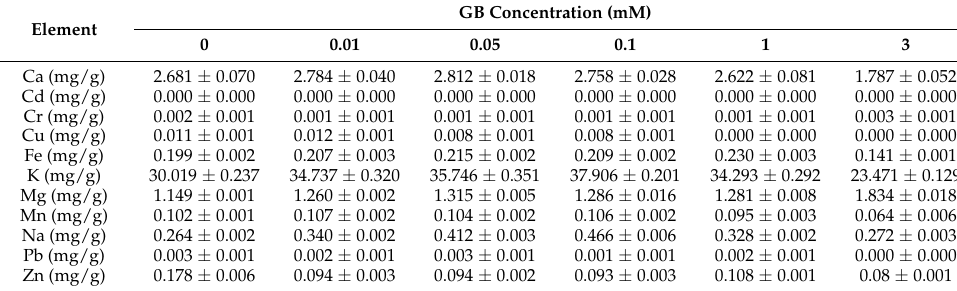
Figure 6. EPR spectra of the S. rebaudiana plants exposed to GB in concentration 0 − 3 mM and a Gd standard at 330 μ g in capillary, at room temperature, 9.46 mW power. The g -values of the signals are indicated ( a ); radical intensity of the S. rebaudiana plants exposed to GB measured by peak-to- peak difference at I 3513 G − I 3527 G ( b ).